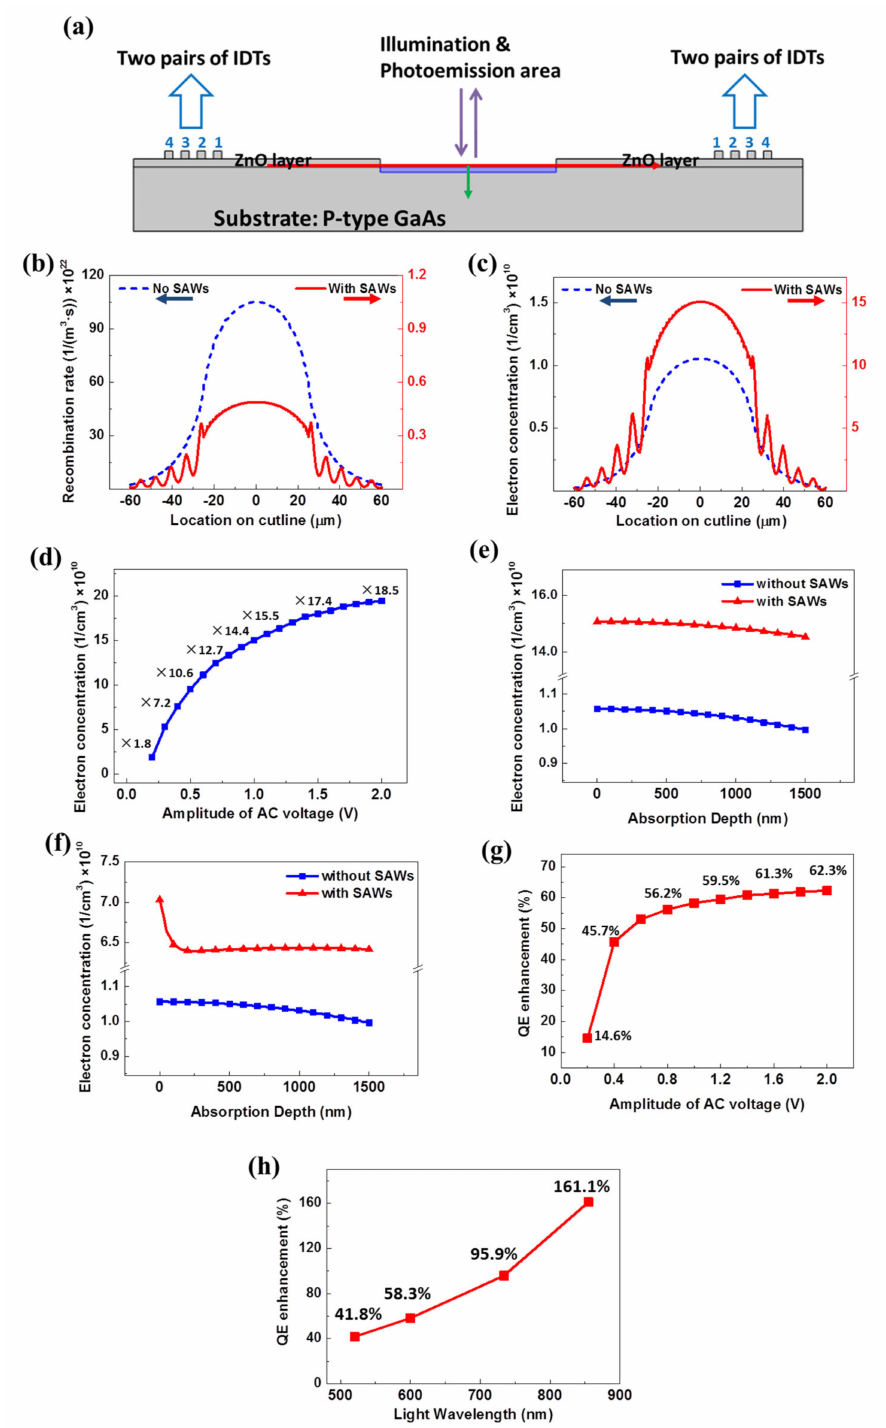
Figure 2. ( a ) Simulation structure of bulk p-type doped GaAs with interdigital transducers (IDTs). ( b ) Comparison of recombination rates with and without SAWs ( V 0 = 1.0 V). ( c ) Comparison of surface electron concentrations with and without SAWs ( V 0 = 1.0 V). ( d ) Increase of electron concentrations vs. AC voltage and SAW intensity. ( e ) Electron concentrations along absorption depth for SAW wavelength ( λ SAW = 9.2 µ m) that was larger than the absorption depth (1.5 µ m) in bulk GaAs. ( f ) Same as ( e ), but for λ SAW = 0.5 µ m, which was smaller than the absorption depth. ( g ) Enhancement of quantum e ffi ciency (QE) under di ff erent amplitudes of AC voltage. ( h ) Enhancement of QE under di ff erent incident light wavelength ( V 0 = 1.0